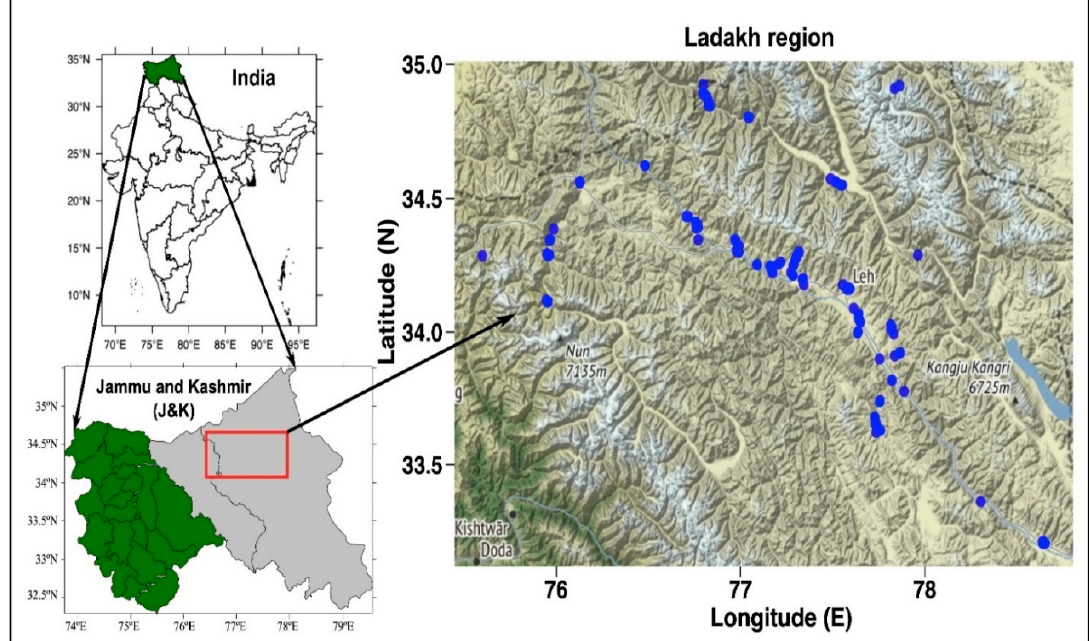
Figure 1. Map of the study area showing the sampling sites ( n = 54) in the Ladakh region.